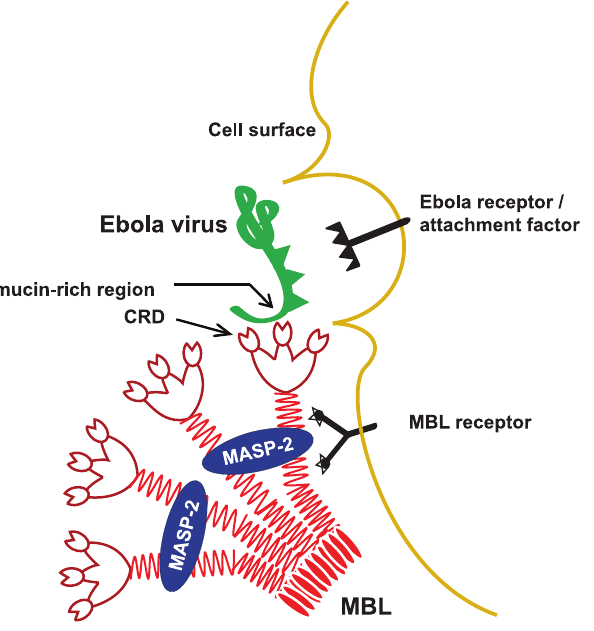
Figure 8. Proposed model of MBL-mediated macropinocytosis of EBOV. MBL carbohydrate recognition domains (CRD) bind to highly glycosylated mucin-rich regions of EBOV GP and the MBL-virion complex is presented to the cell surface. Then MBL binds to cognate cellular receptors, such as C1QBP or calreticulin [6] via MBL collagenous stalks. In this manner, MBL concentrates virus at the cell surface and may facilitate cross-linking of EBOV to its cognate receptor or to other attachment factors such as dectin-2, which may facilitate subsequent membrane fusion and internalization. The relatively large size of EBOV particles (800 to 1,400 nm) is amenable to bulk fluid-phase uptake pathways such as macropinocytosis which is the canonical pathway for EBOV entry. Our data indicate that MBL also mediates internalization of virus via macropinocytosis but suggests that MBL-mediated uptake preferentially utilizes microtubules compared with the canonical EBOV pathway which is dependent on both microtubules and actin.